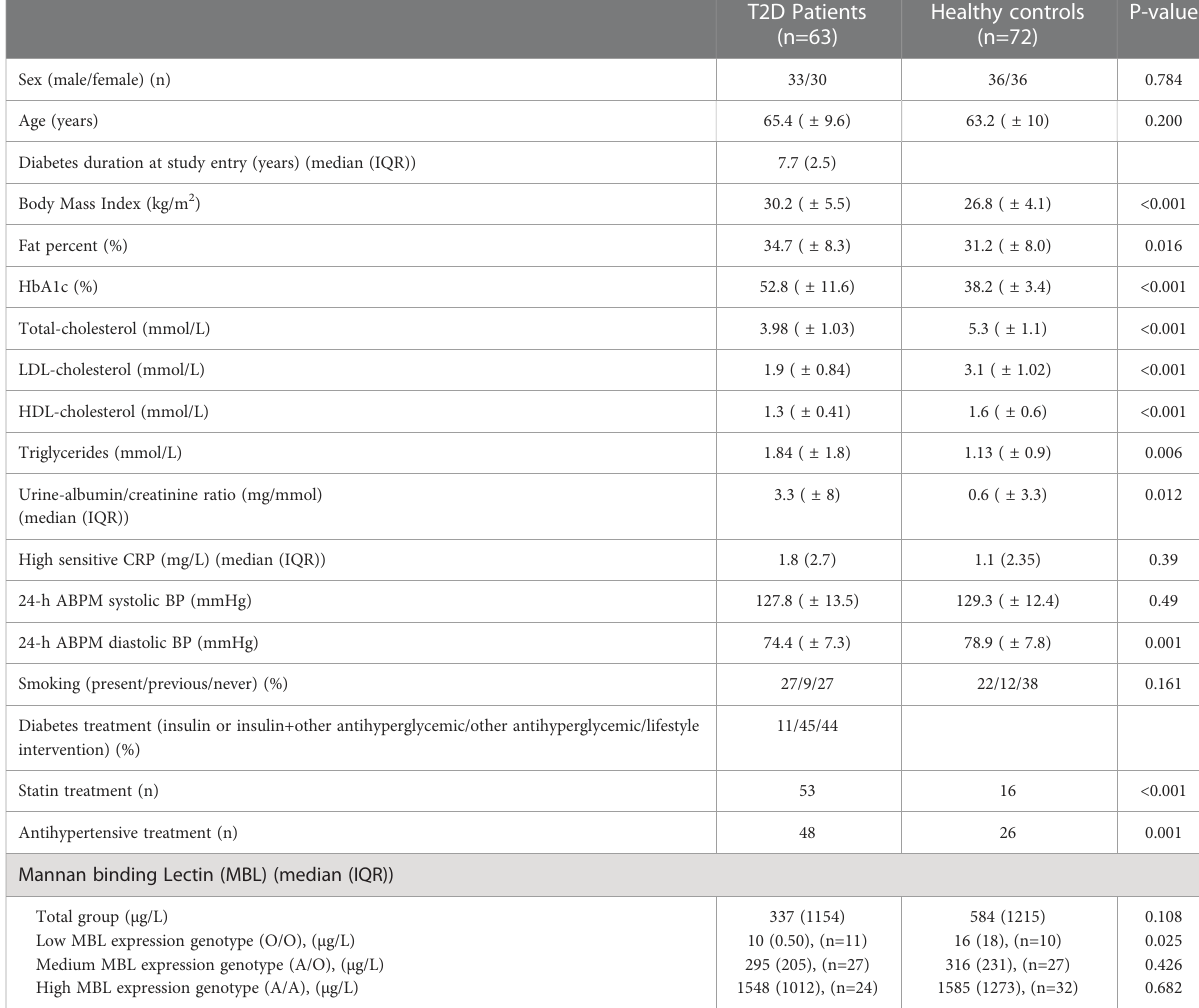
TABLE 2 Characteristics of the participants at 5-year follow-up. Data are mean ± SD unless other